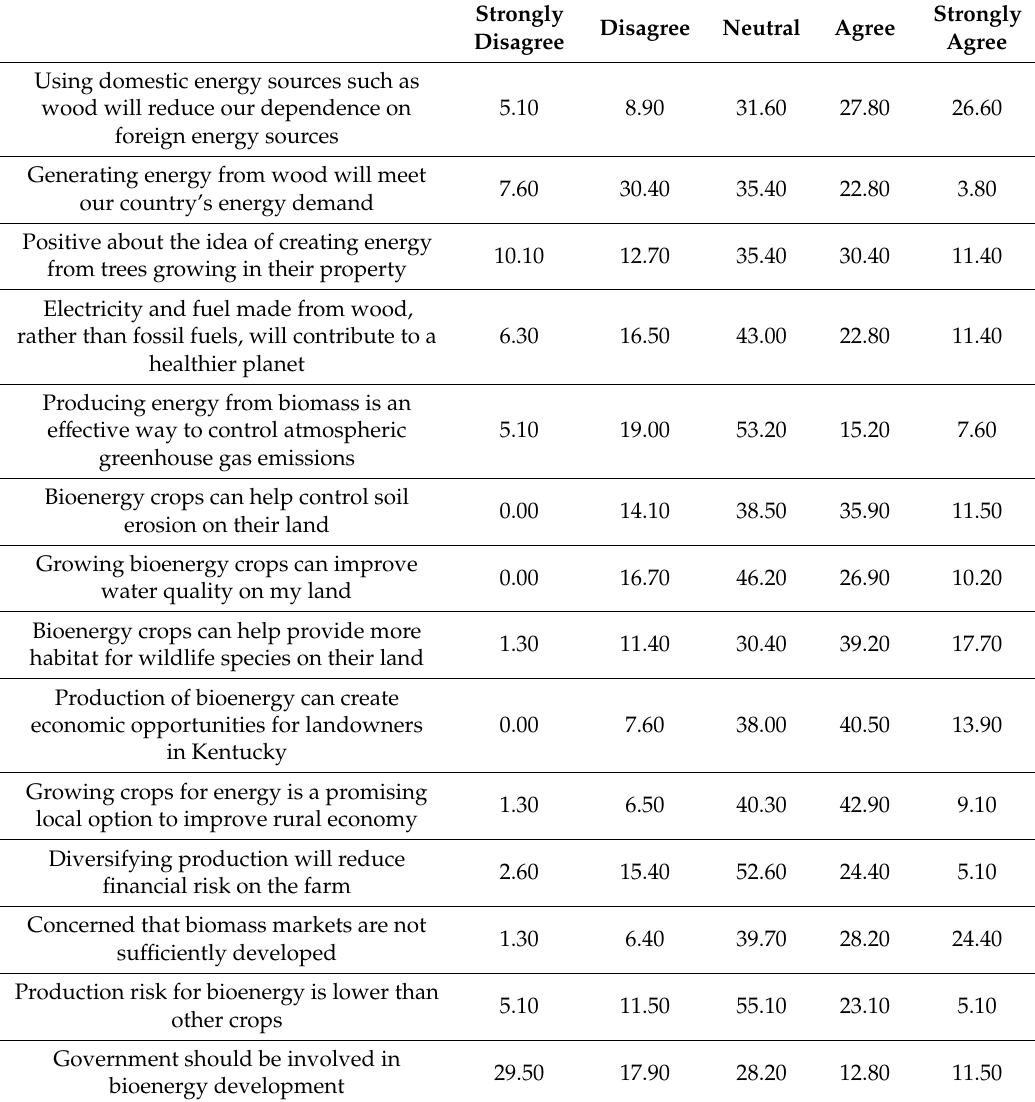
Table 4. Survey results on landowners’ opinions on bioenergy (in